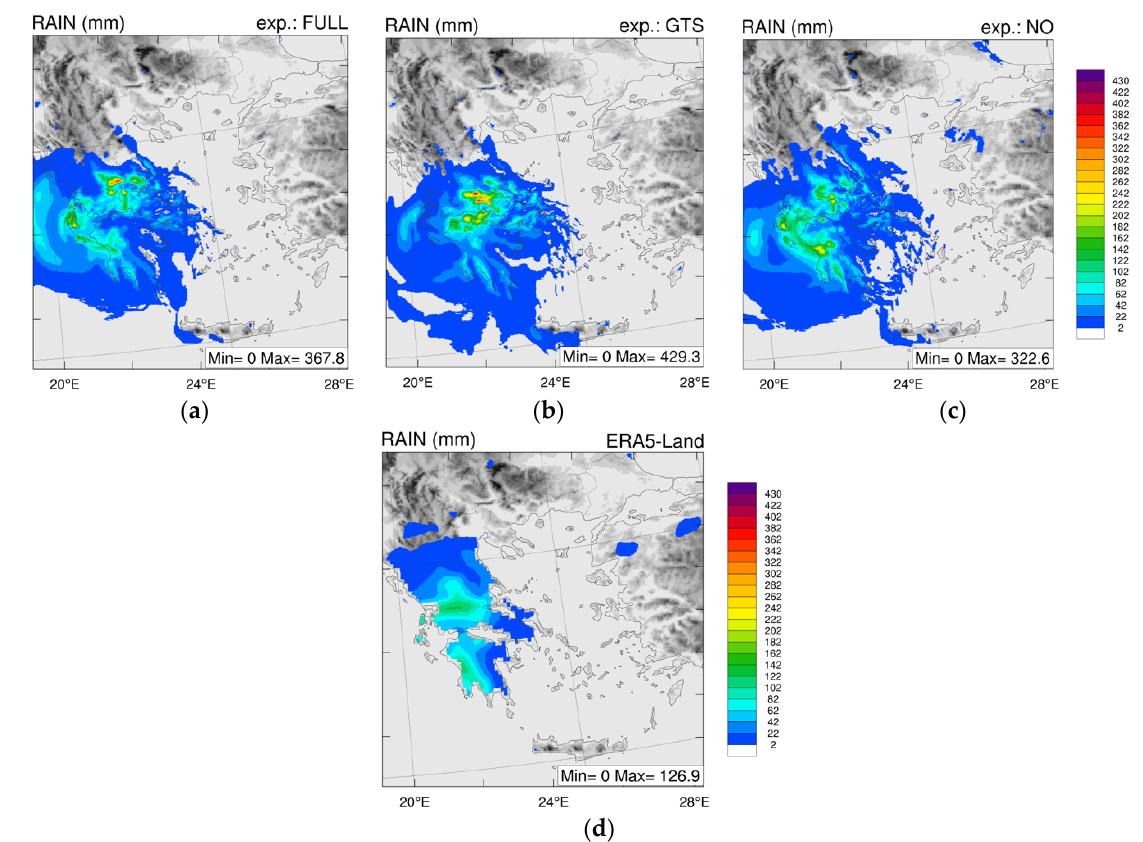
Figure 16. Spatial distribution of precipitation accumulated from 12 to 18 UTC on 18 September 2022. In ( a ), the accumulated precipitation as predicted from the FULL simulations is depicted. In ( b ), the accumulated precipitation as predicted from the GTS simulations is depicted. In ( c ) and ( d ), the accumulated precipitation from the NO simulation and from the reanalysis data ERA5-Land is shown, respectively.